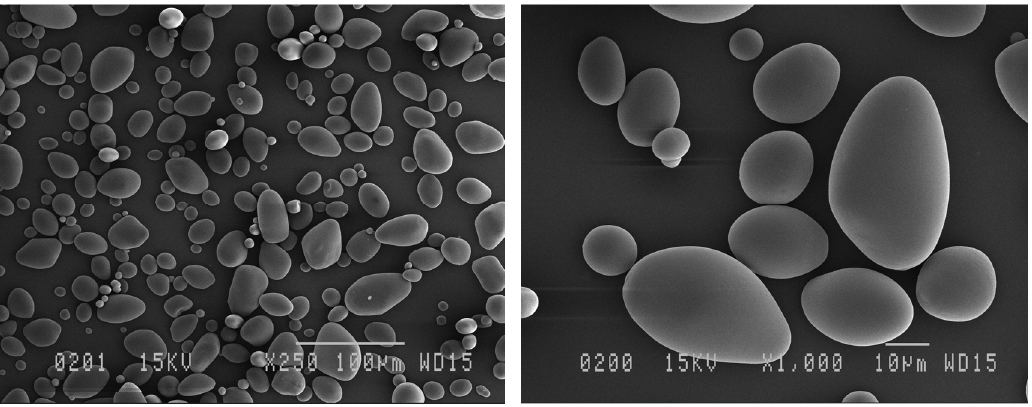
Figure 2. SEM images of native potato starch granules from the “Gabrielle” variety.